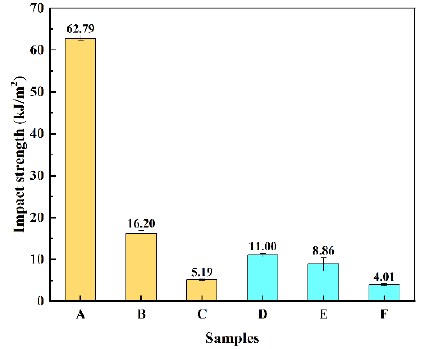
Figure 6. Impact strength of the composites.